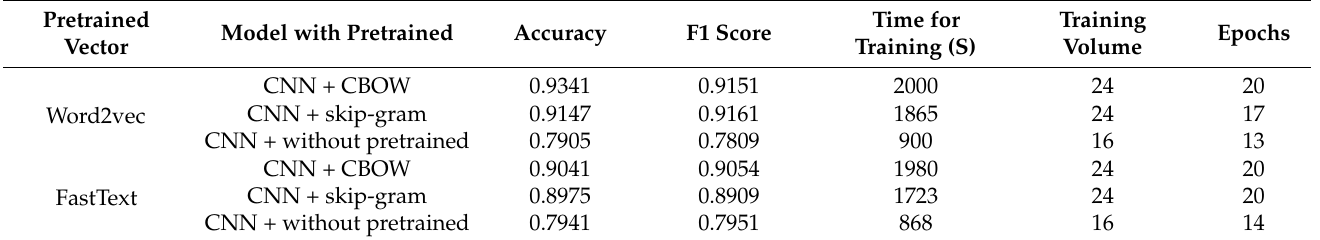
Table 7. Comparison of the experimental